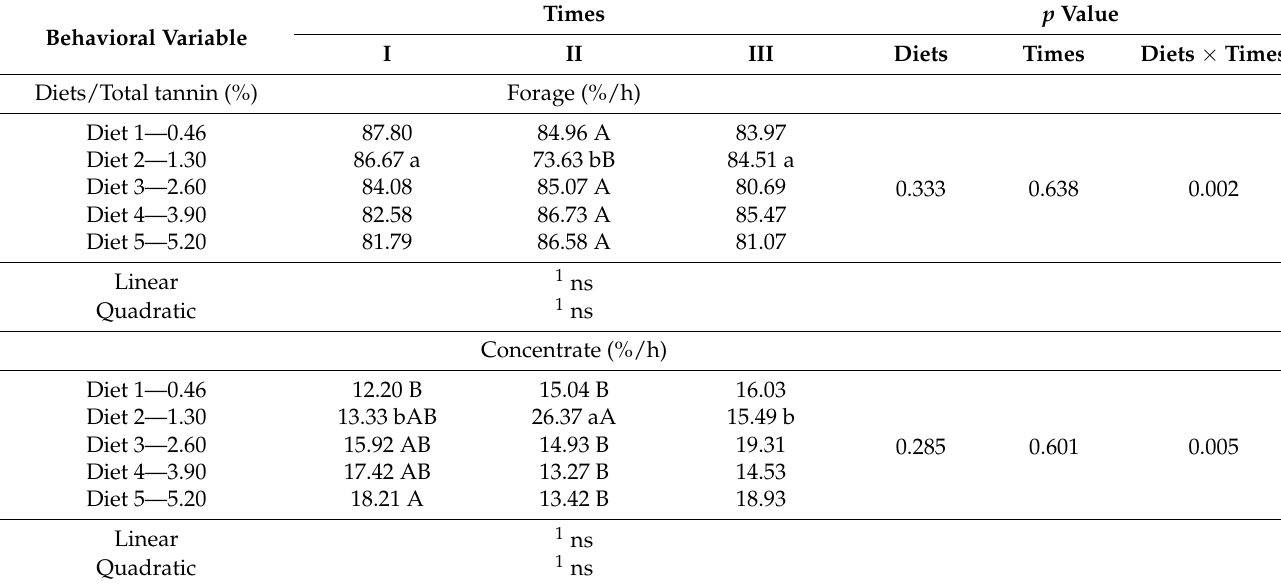
Table 3. Percentage of time spent on a daily intake of forage and concentrate by lactating dairy cows as a function of dietary tannin levels, in three times of the study periods.